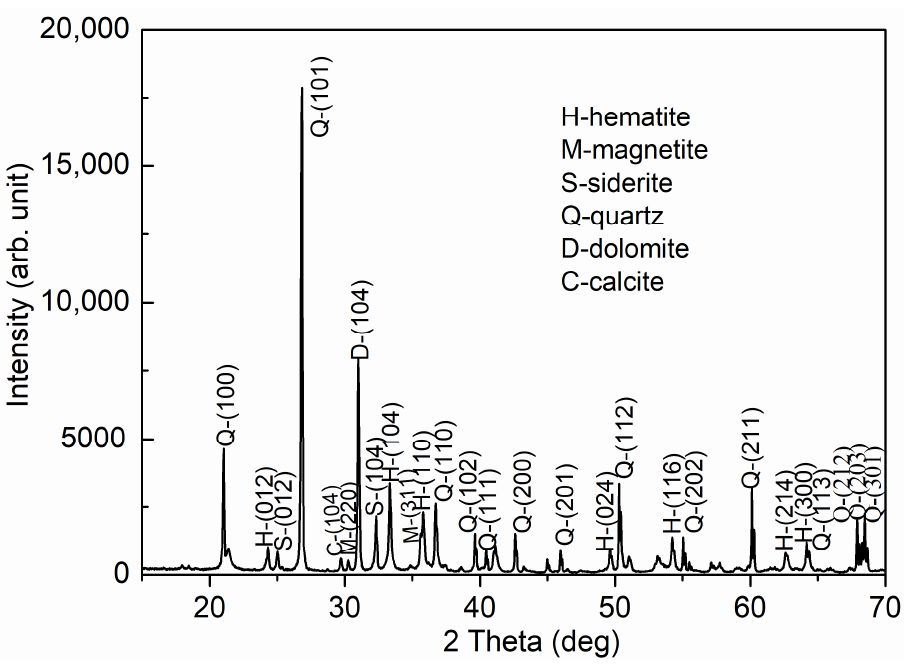
Figure 1. XRD analysis of raw ore.